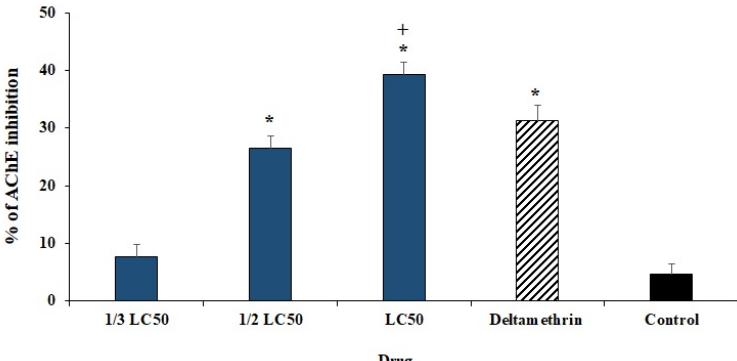
Figure 5. The effect of Elettaria cardamomum L. essential oil (ECEO) on AChE inhibition activity of Hyalomma anatolicum larvae. LC 50 : the lethal concentration 50. Data are stated as mean ± SD (n = 3). * p < 0.001 significant difference with control group; + p < 0.001 significant difference with deltamethrin.